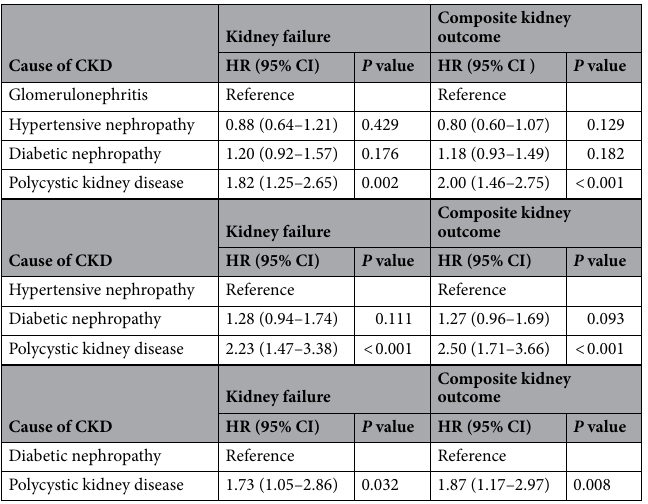
Table 2. Relative risk for kidney outcomes according to the CKD causes. CI, confidence interval; CKD, chronic kidney disease; HR; hazard ratio.